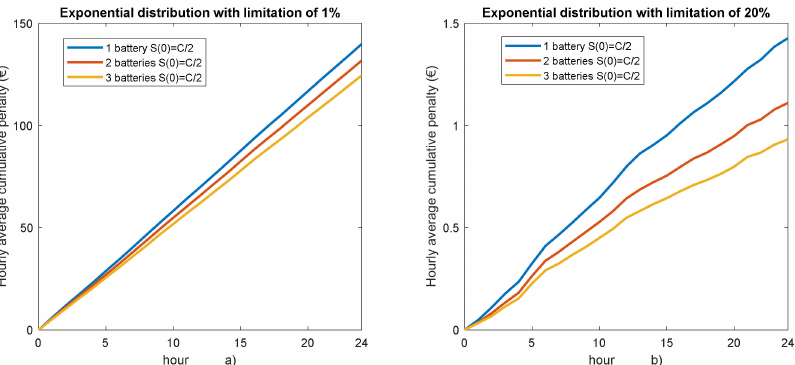
Figure 11. Hourly average cumulative theoretical penalty in 1 day with the Exponential distribution and the ramp-rate percentage limitations of 1% ( a ) and 20% ( b ).